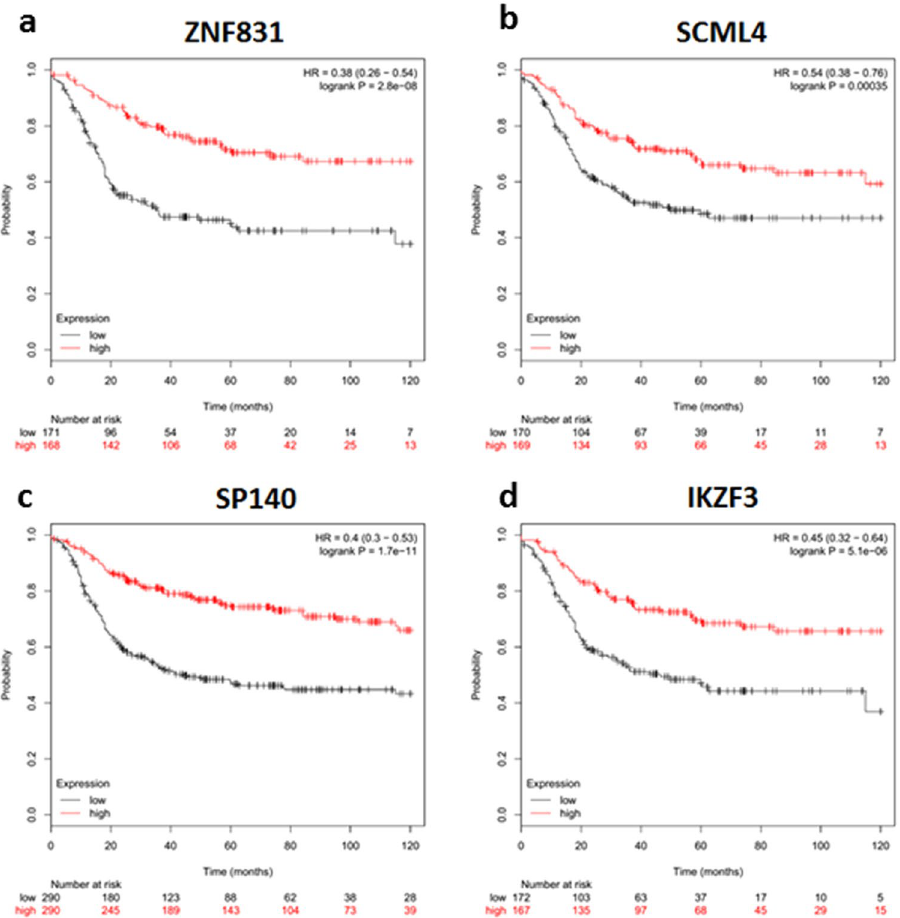
Figure 5. Survival plots depicting a better relapse free survival in breast cancer of the basal subtype with a high expression of: ( a ) - ZNF831, ( b )- SCML4, ( c ) - SP140 and ( d ) -